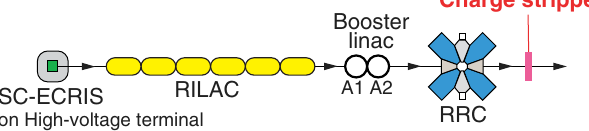
FIG. 1. Acceleration scheme of the experiment. The charge stripper is located downstream of the RRC. The uranium ions were extracted from the SC-ECRIS on the high-voltage platform of the Cockcroft-Walton preinjector in the RILAC facility. The first two resonators (A1 and A2) of the booster linac were used for the beam energies of 14 and 15 MeV = nucleon , where the RRC was operated at the harmonic number of h ¼